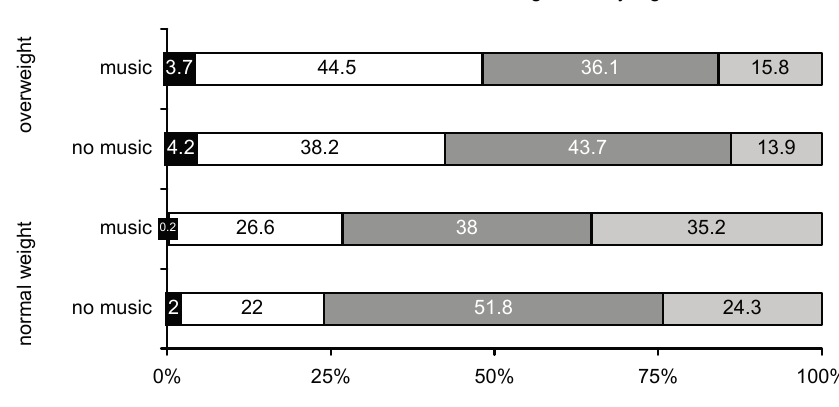
Figure 2. Proportion of time spent in activities of different intensities during the exercise session with and without attentional distraction by music in normal-weight and overweight